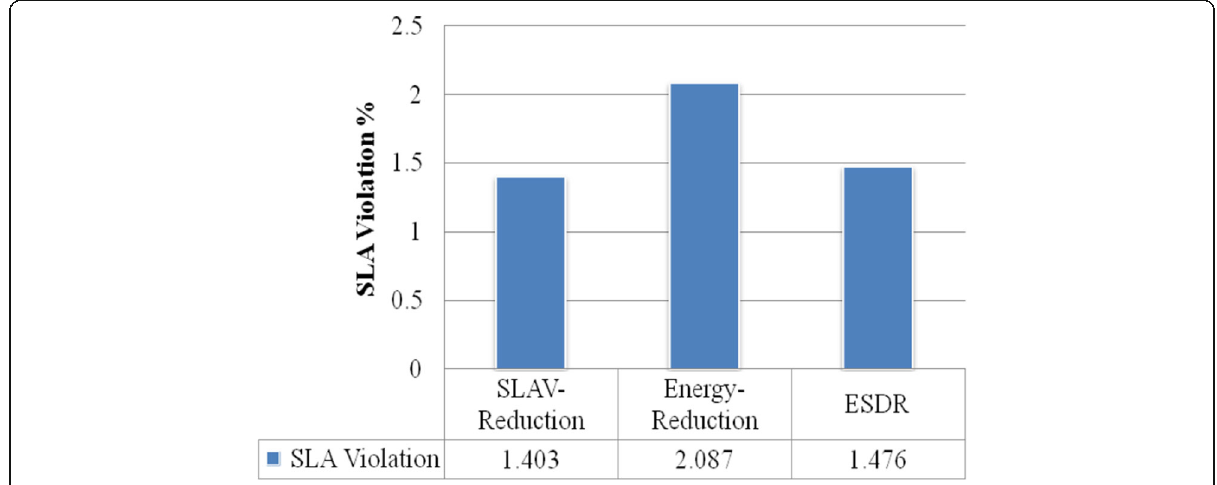
Fig. 4 Comparison of SLA violations for different